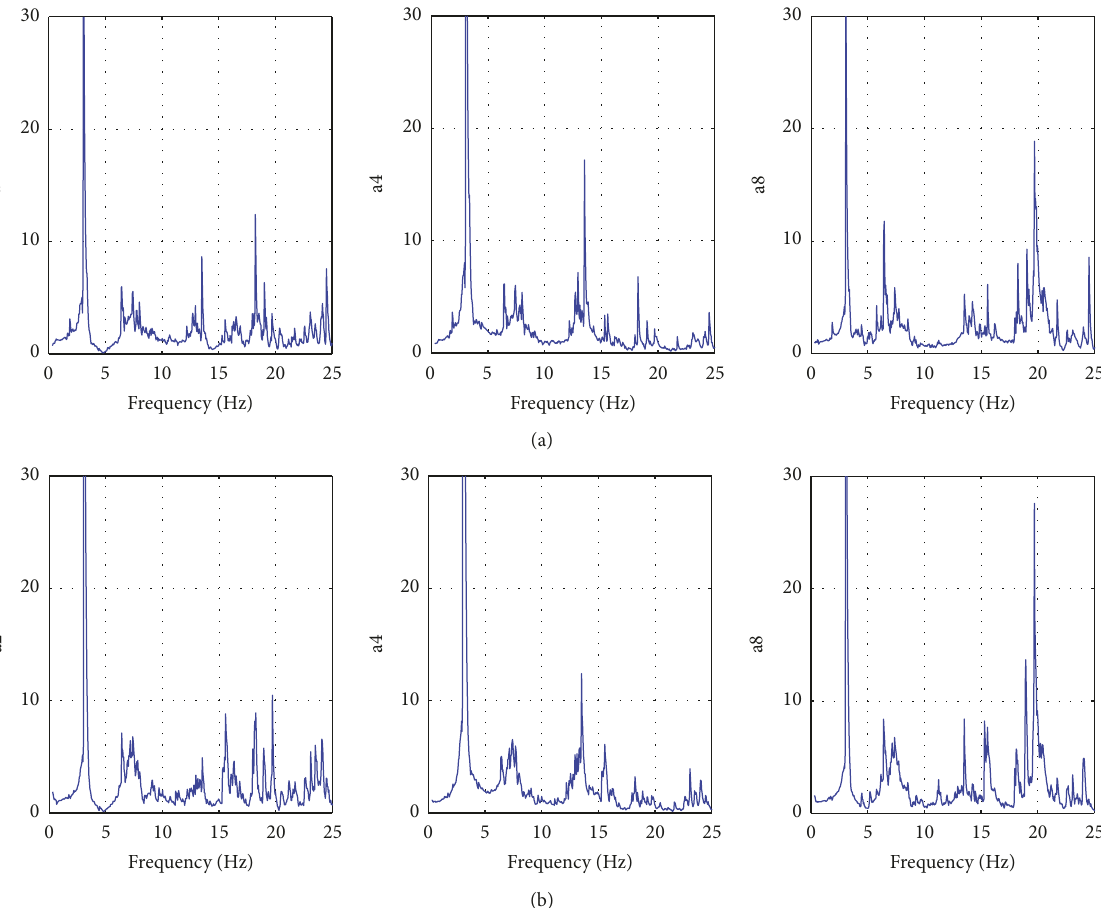
Figure 9: Semiactive connected (SAC) configuration, experimental pseudo frequency response functions. Ground acceleration 𝑥 direction, voltage level (a) 0-1V and (b) 0–2.5 V. El Centro test PGA 0.6g.